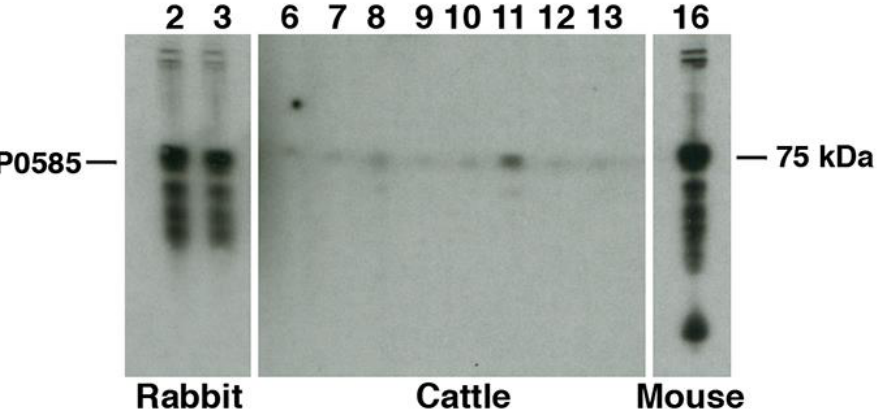
Figure 9. Antigenicity of MAP_0585. Immunoblot analysis shows MAP_0585 reacts strongly to the rabbit antisera developed to the EtOH extract (3993 in lane 2 and 3995 in lane 3) and the protein is also detected by a mAb to the maltose bind protein affinity tag (lane 16). However, the protein is not antigenic in cattle (lanes 9 and 12 are healthy cattle and all other lanes are JD cattle). The position of the MAP_0585 is indicated in the left margin and the host generating antibody is indicated beneath the blot.